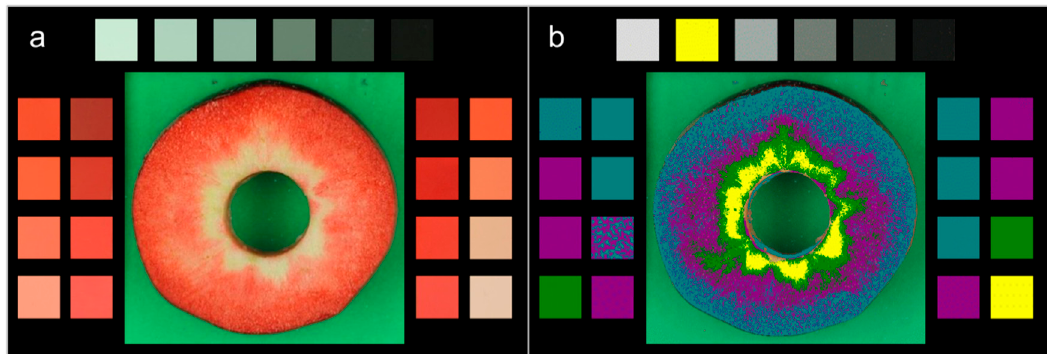
Figure 1. ( a ) Image of the equatorial slice of a red-fleshed apple that was taken together with four red color charts (No. 39, 43, 45, 46) of the Royal Horticultural Society (RHS) and a grey scale of ColorChecker. Red color charts and grey scale served as calibration. ( b ) False-color image of the photograph depicted in A. The four color classes were identified based on the L-values of the RHS color charts.